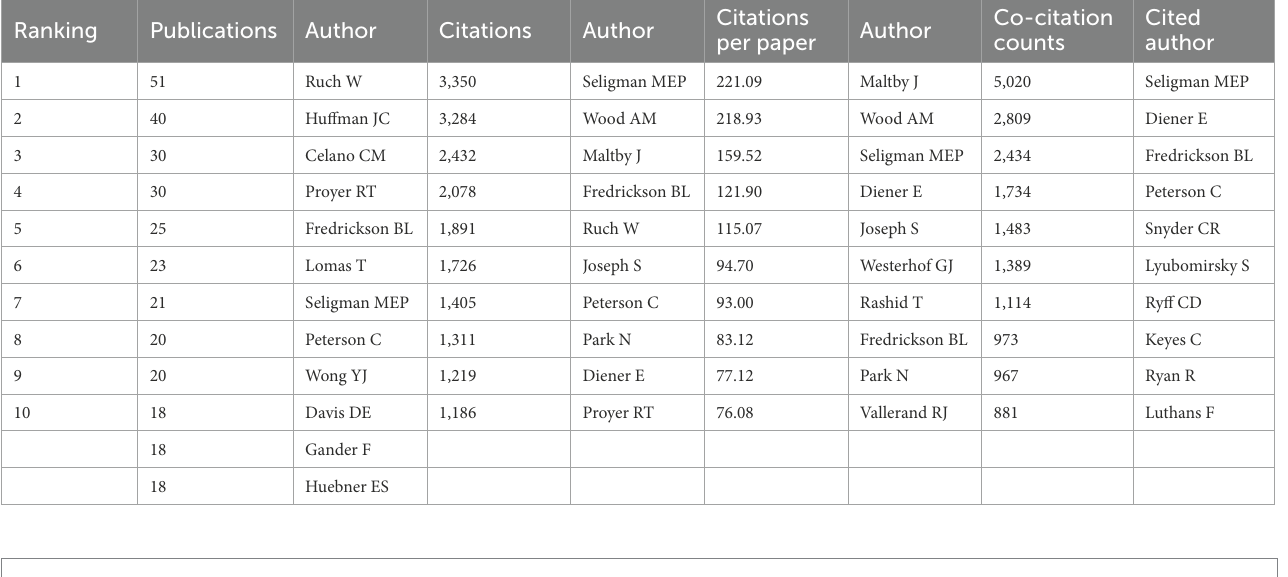
TABLE 4 Top 10 active authors and co-authors in positive psychology